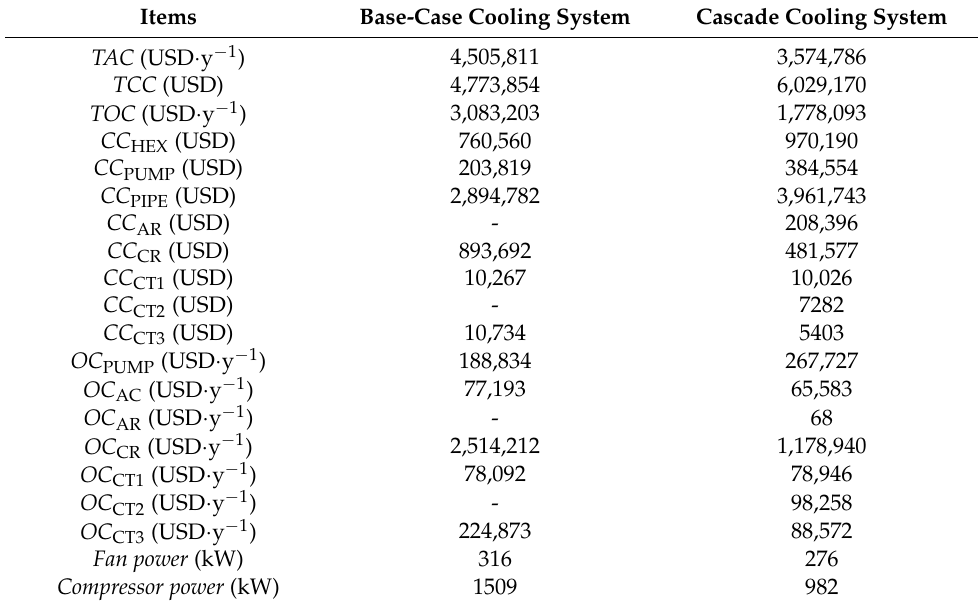
Table 5. Comparison of results between base-case and cascade cooling systems.